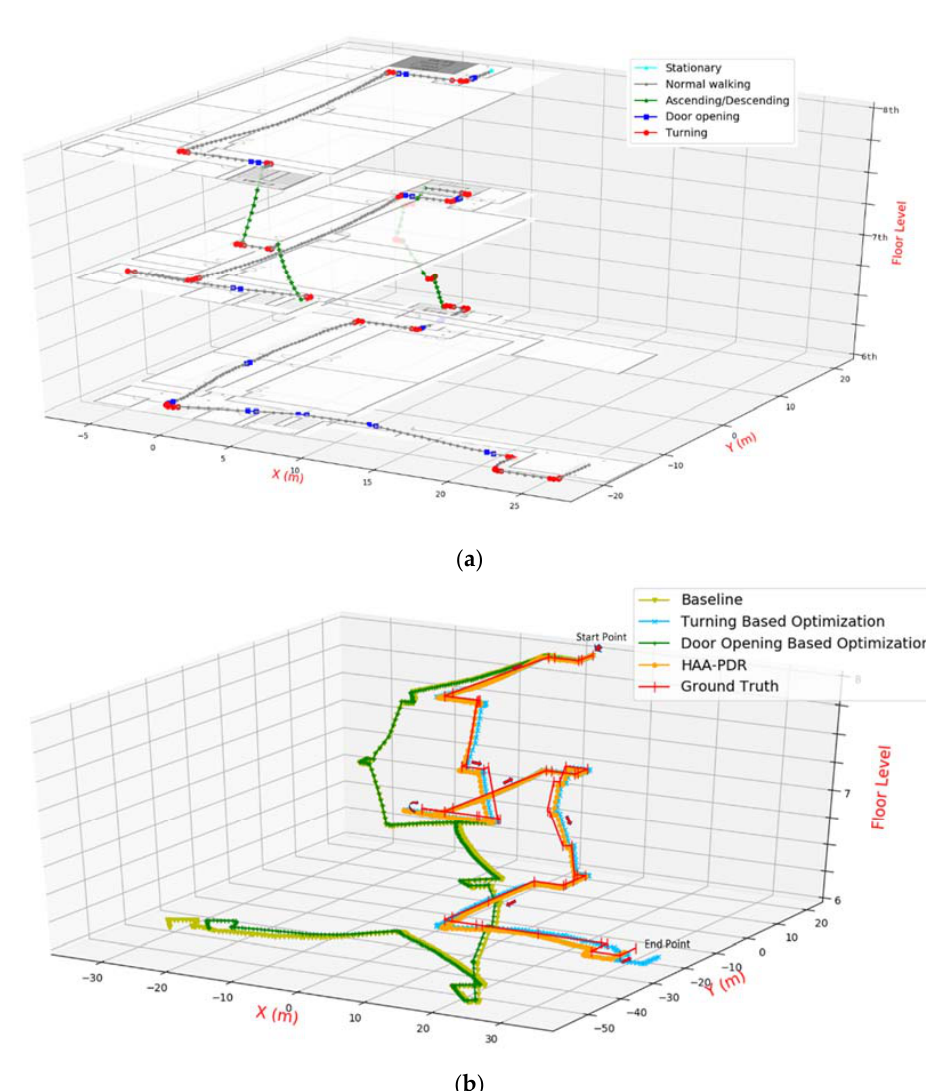
Figure 17. The results of path reconstruction at different floor levels. We also evenly interpolate the height according to the number of steps in each staircase. ( a ) Different activities along the path estimated by our HAA-PDR. ( b ) The complete paths from 3D perspective; the vertical red lines mark the places of the reference points for assessment along the ground truth trajectory.